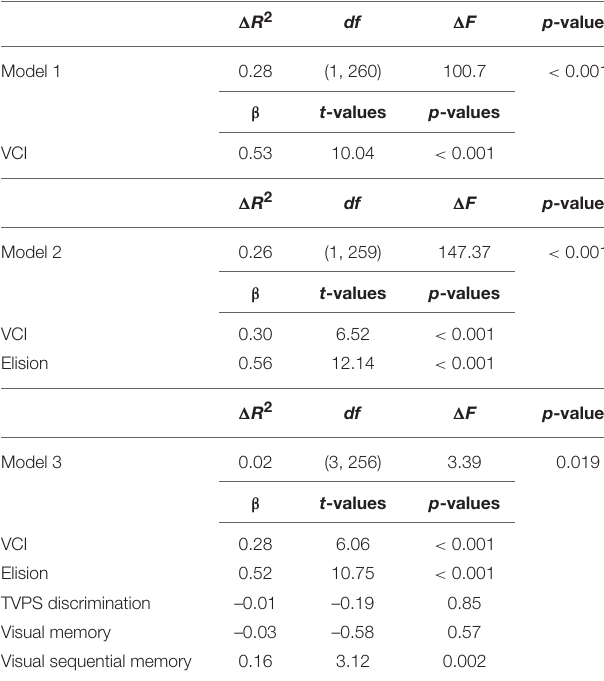
TABLE 3 | Hierarchical regression predicting basic reading performance when controlling phonological awareness.